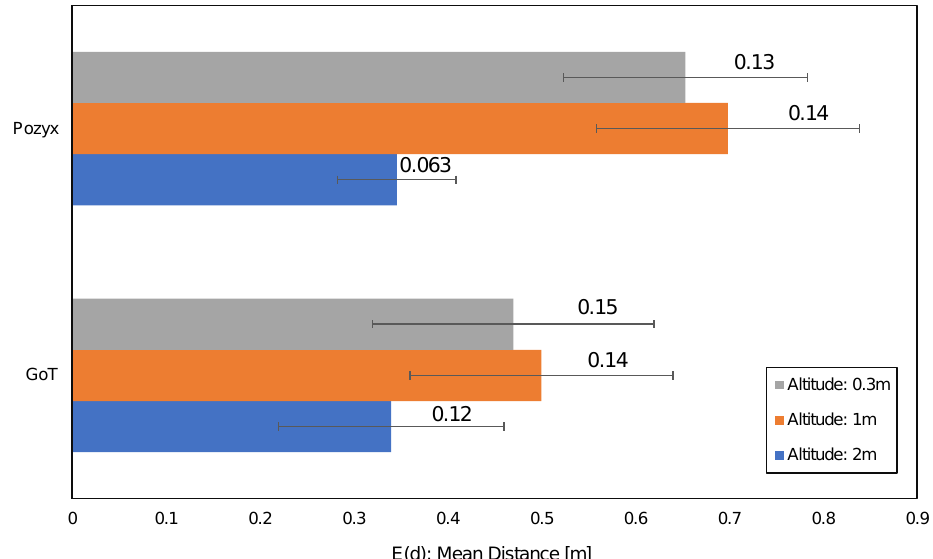
Figure 8. Aggregated mean error distance and standard deviation (as error bars) at 3 heights.